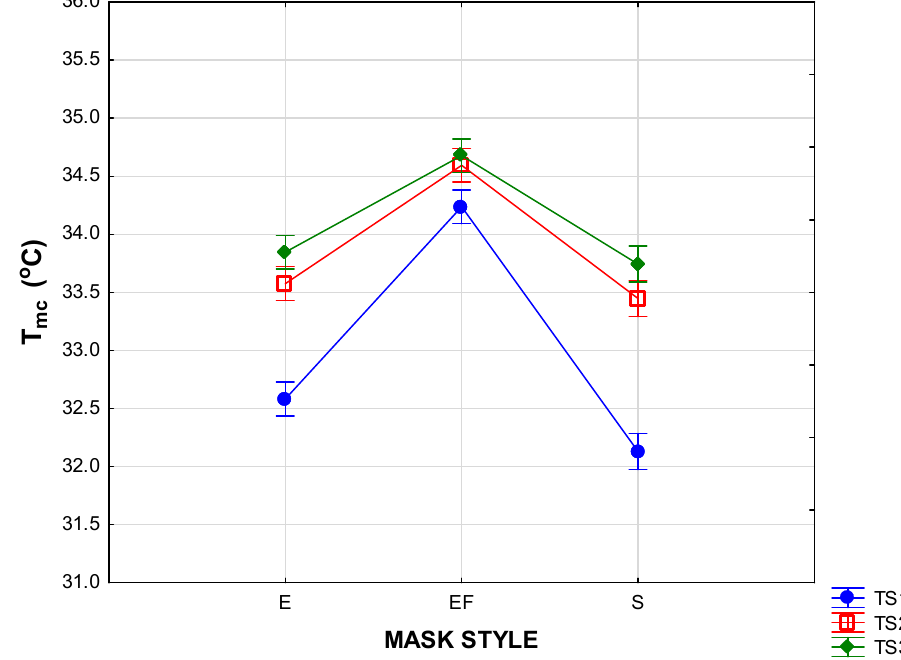
Figure 5. Two-way ANOVA of T mc per mask style according to time segment.